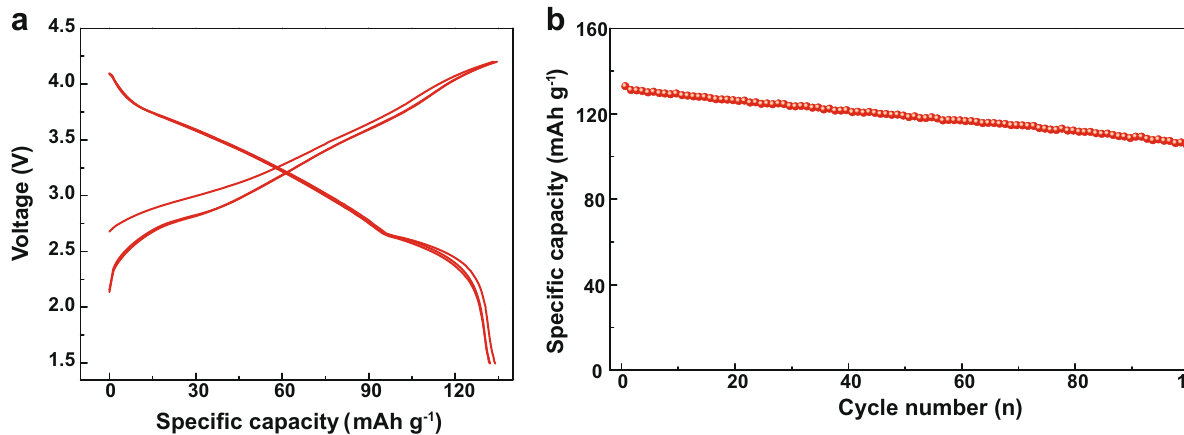
Fig. 5 Na-ion electrochemical energy storage performances in full-cell con fi guration. Galvanostatic charge/discharge voltage pro fi les between 1.5 and 4.2 V ( a ) and cycling performance at 250 mA g − 1 for hard carbon||NLNFMB full cell ( b ).